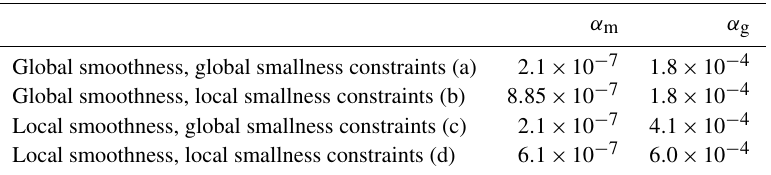
Table 2. The α values derived for simultaneous usage of local and global smallness and smoothness constraints. Scenario (a) is a reminder of the values obtained in Sect. 4.2 when only global constraints are used.